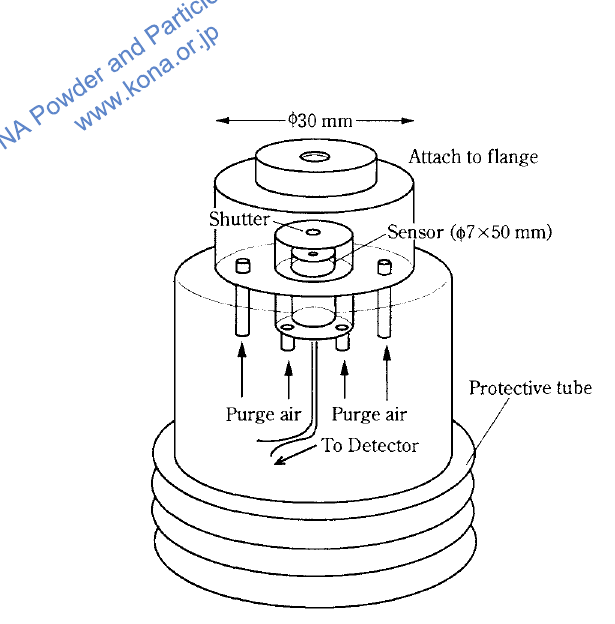
Schematic diagram of the sensor extremity